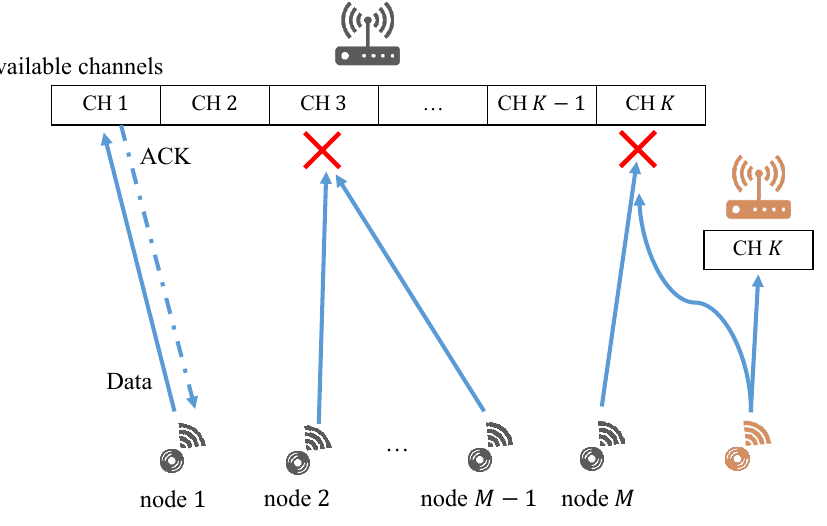
Figure 2. Channel access model.